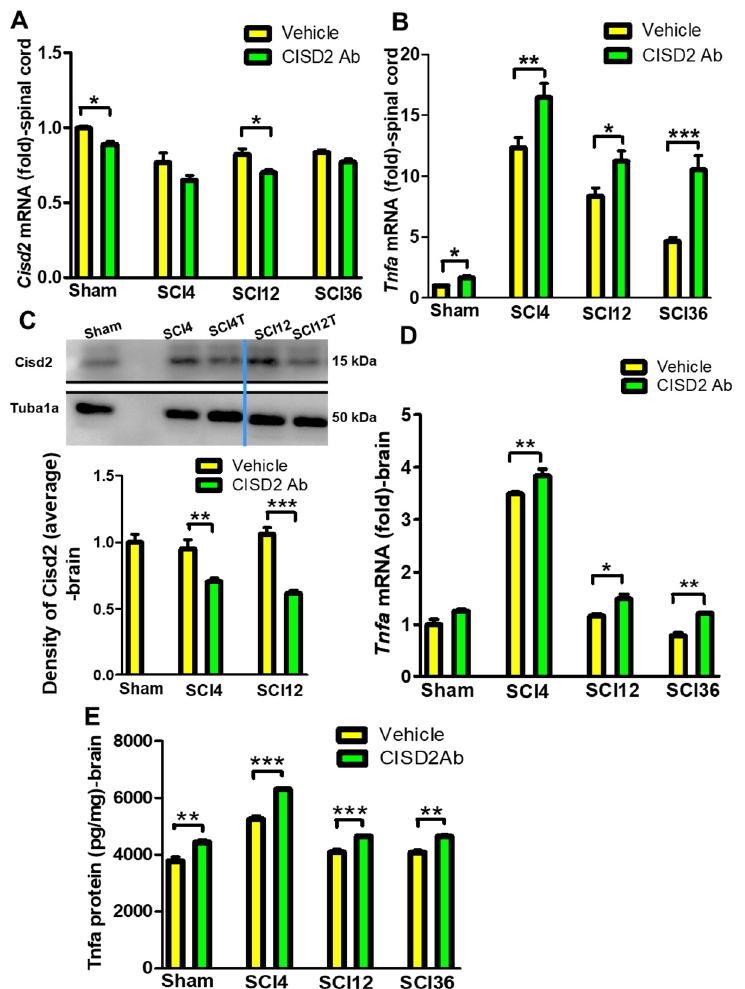
Figure 4. Inhibition of Cisd2 using anti-CISD2 neutralizing antibodies exacerbated the inflammatory response in the injured spinal cord and spinal cord injury (SCI)-mediated inflamed brain of mice subjected to spinal cord hemisection. ( A ) The spinal cord levels of Cisd2 mRNA were decreased in the 4, 12, and 36 h post-SCI groups. ( B ) The differences in the spinal cord levels of Tnfa mRNA between the anti-CISD2 antibody-treated and vehicle-treated groups increased by each of these time points. ( C ) The confirmation of Cisd2 knockdown in the brain of rats subjected to spinal cord hemisection. The brain levels of Tnfa mRNA ( D ) and protein ( E ) in the anti-CISD2-treated SCI group were higher than those in the vehicle-treated SCI group at each time point. Vertical bars indicate mean ± standard error of mean of mRNA ( n = 6 for each group) and protein (for Western blot, n = 3; for enzyme-linked immunosorbent assay (ELISA), n = 6) levels. * p < 0.05, ** p < 0.01, and *** p < 0.001 (pair-wise multiple comparisons between groups were performed using the Newman–Keuls test).